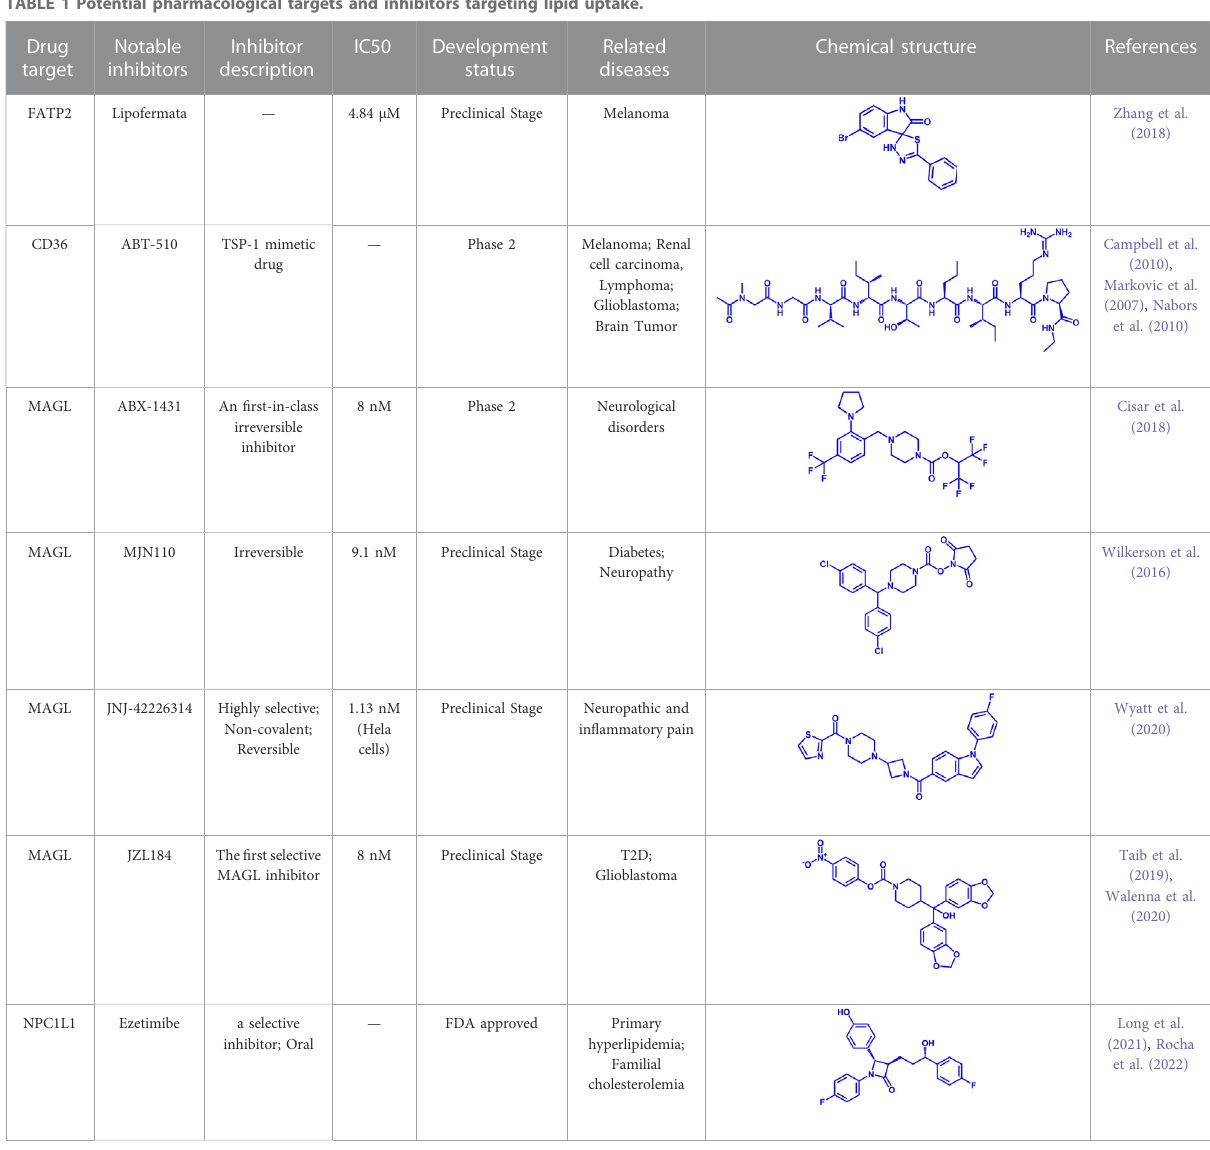
TABLE 1 Potential pharmacological targets and inhibitors targeting lipid